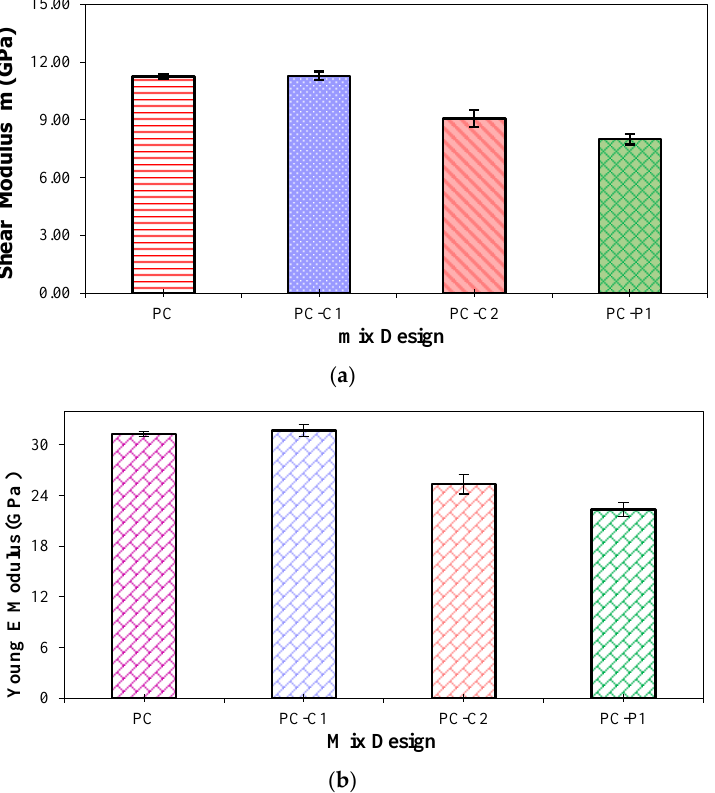
Figure 7. Elastic characteristics of polymer concretes: ( a ) Shear Modulus, ( b ) Young Modulus. By adding fibers to PC, all mixes showed indistinctly an increase in the modulus with sample age and being stabilized after a period of 5 to 7 days (Figure 8). This can be at- tributed to the progress of the curing reaction taken end at the 7 days as maximum leading to the formation of polymeric epoxy structures [16]. It should be mentioned that the mod- ulus of elasticity records for unreinforced PC displayed are in accordance with the values described in literature for epoxy-based PC [11,44].